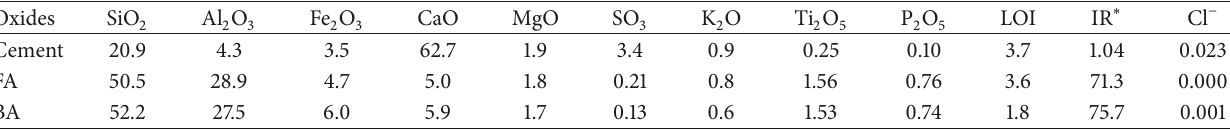
Table 1: Chemical composition of raw materials: coal bottom ash (BA), coal fly ash (FA), and cement (%). Oxides SiO 2 Cement BA